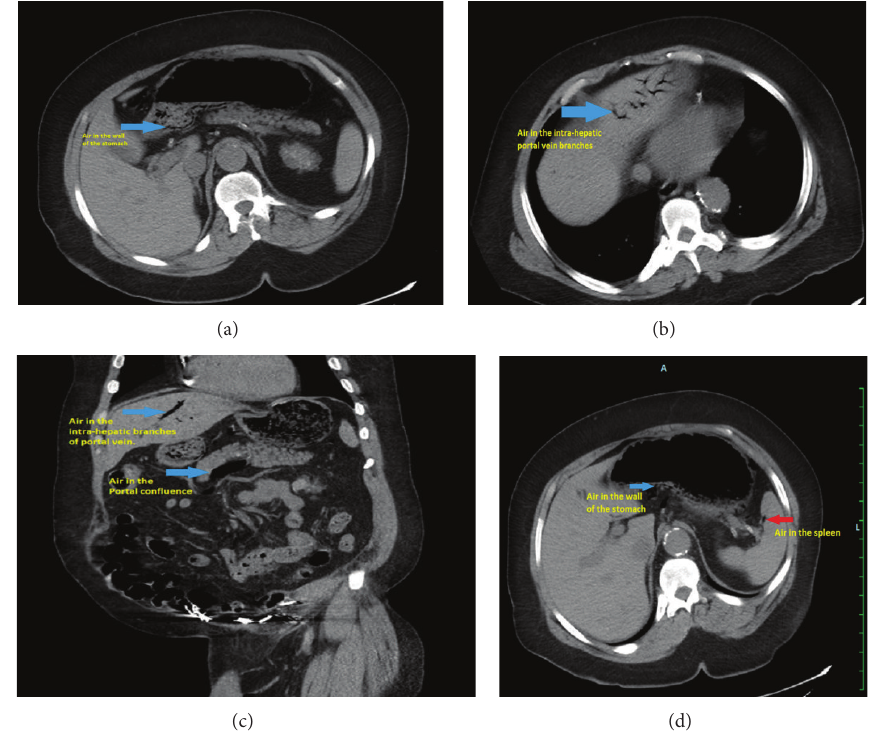
Figure 1: (a) Blue arrow showing air in the wall of the stomach. (b) Blue arrow showing air in the intrahepatic branches of portal vein. (c) Coronal section of the abdomen with upper arrow showing air in the intrahepatic branch of portal vein and lower arrow showing air in the area of confluence of portal vein. (d) Blue arrow showing air in the stomach wall and red arrow showing air in the